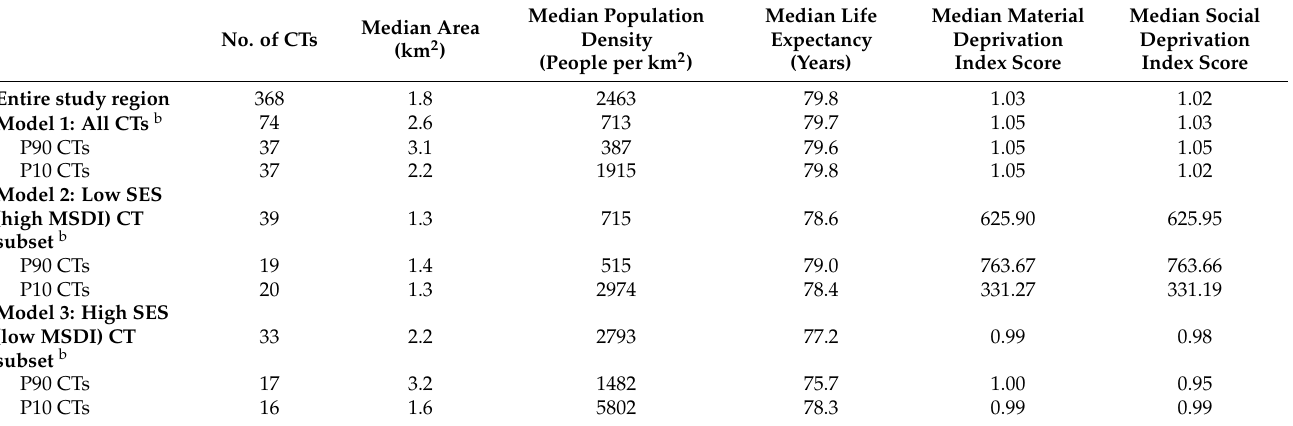
Table 1. Baseline descriptive characteristics of census tracts (CTs) in the entire study region and in each of the three difference-in-differences models (all CTs, low socioeconomic status (SES) CTs, and high SES CTs), Metro Vancouver, 1990–1995 a